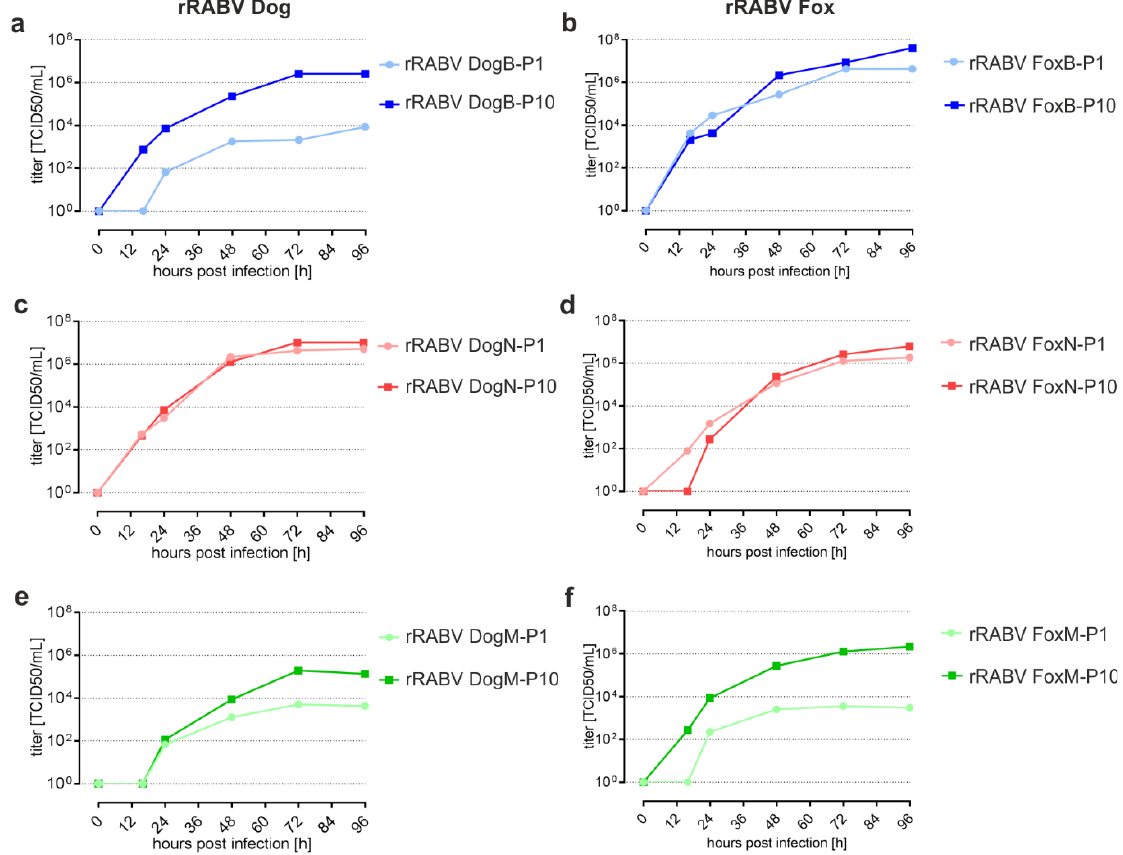
Figure 2. Replication kinetics of cell culture-passaged rRABV Dog and rRABV Fox. Replication curves were determined after infection of the respective cell lines at an MOI of 0.01. ( a ) rRABV DogB-P1 and -P10 on BHK cells. ( b ) rRABV FoxB-P1 and -P10 on BHK cells. ( c ) rRABV DogN-P1 and -P10 on Na 42/13 cells. ( d ) rRABV FoxN-P1 and -P10 on Na 42/13 cells. ( e ) rRABV DogM-P1 and -P10 on MDCK-II cells. ( f ) rRABV FoxM-P1 and -P10 on MDCK-II cells. Shown are representative replication curves for the indicated viruses.